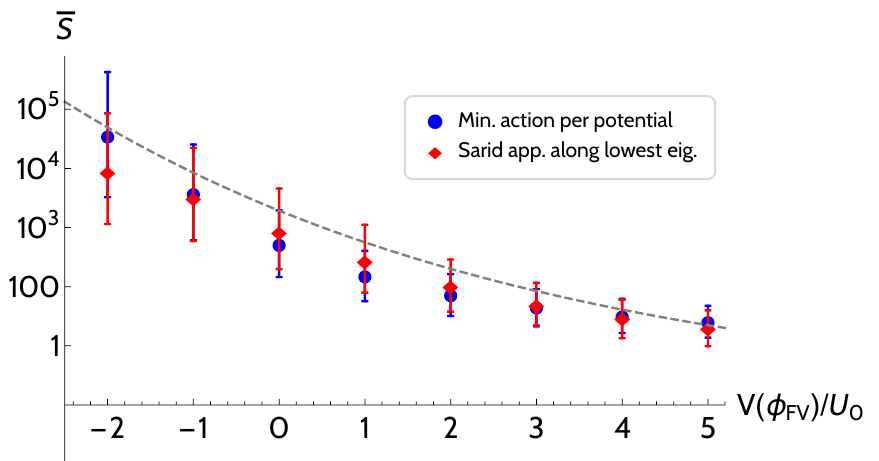
Figure 8. Distribution of lowest action per potential and Sarid approximation [46] along the lowest barrier direction, in terms of false vacuum height. The (cid:12)t in eq. (4.6) is shown for comparison with previous